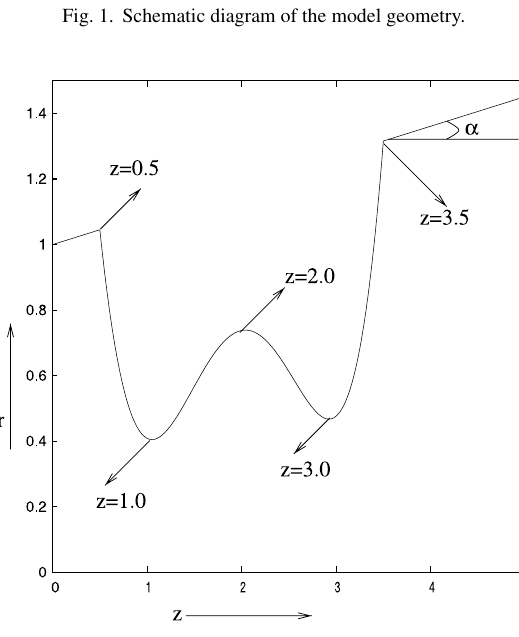
Fig. 1. Schematic diagram of the model geometry.